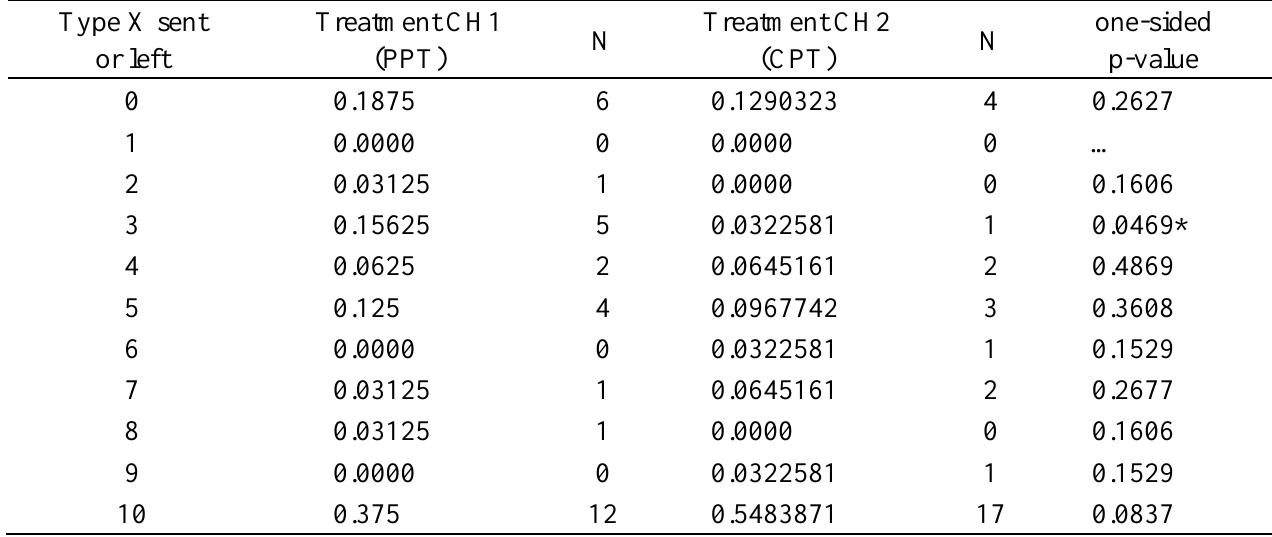
Table A2. Proportions tests of Type X data for strategy method treatments CH1 and CH2.